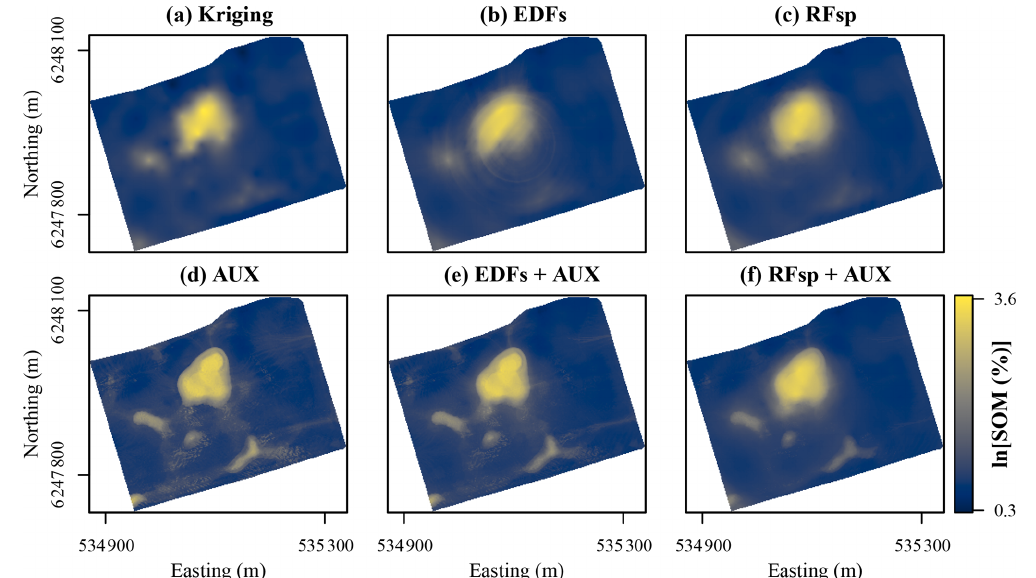
Figure 8. Prediction of soil organic matter (SOM) contents for the topsoil at Vindum using (a) kriging, or random forest models trained with (b) Euclidean distance fields (EDFs), (c) distances to observations (RFsp), (d) auxiliary data (AUX), (e) EDFs in conjunction with AUX, or (f) RFsp in conjunction with AUX. Easting and northing for UTM zone 32N (ETRS89).